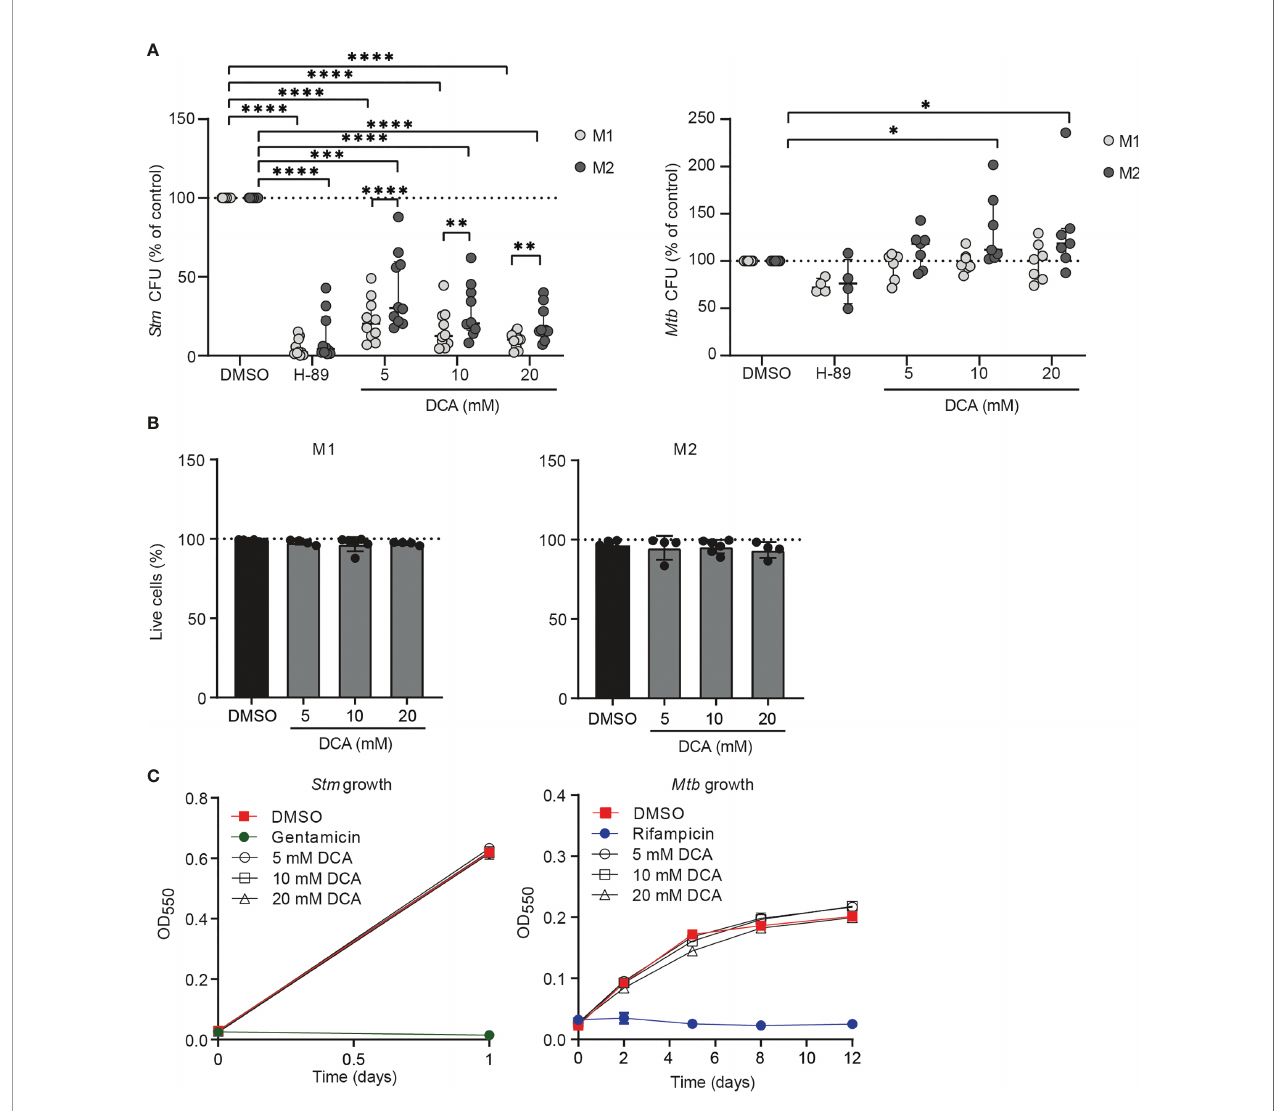
FIGURE 6 | DCA markedly inhibited bacterial outgrowth of Stm but not Mtb. (A) Stm - (left panel) or Mtb -infected (right panel) M1 (light grey dots) or M2 (dark grey dots) were treated with H-89 (10 µM), PDK inhibitor DCA (5-20 mM) or an equal volume of vehicle control DMSO (0.1% v/v) overnight. Data represent the median ± interquartile range of ten different donors ( Stm -infection) or seven different donors ( Mtb -infection). CFUs are expressed as percentage of DMSO. Differences were signi fi cant by RM Two-way ANOVA with Dunnett ’ s-multiple comparison test to compare DMSO with DCA or with Sidak ’ s multiple comparison test to compare M1 with M2 in each test condition. (B) Percentage of live M1 (left panel) and M2 (right panel) cells (i.e. PI-negative cells) after treatment with DCA (5-20 mM) or vehicle control DMSO (0.1% v/v) overnight. Data represent the median ± interquartile range of at least four different donors. Differences were tested by RM one-way ANOVA with Dunnett ’ s multiple test correction against DMSO. (C) Stm (left panel) and Mtb growth (right panel) after addition of DCA (5-20 mM), gentamicin (50 µg/ml), rifampicin (20 µg/ml) or vehicle control DMSO (0.1% v/v) to liquid Stm (left panel) or Mtb (right panel) broth cultures. Data represent the mean optical density (OD) at 550 nm ± S.D. of triplicates of a representative experiment out of three experiments. *p < 0.05, **p < 0.01, ***p < 0.001, ****p <